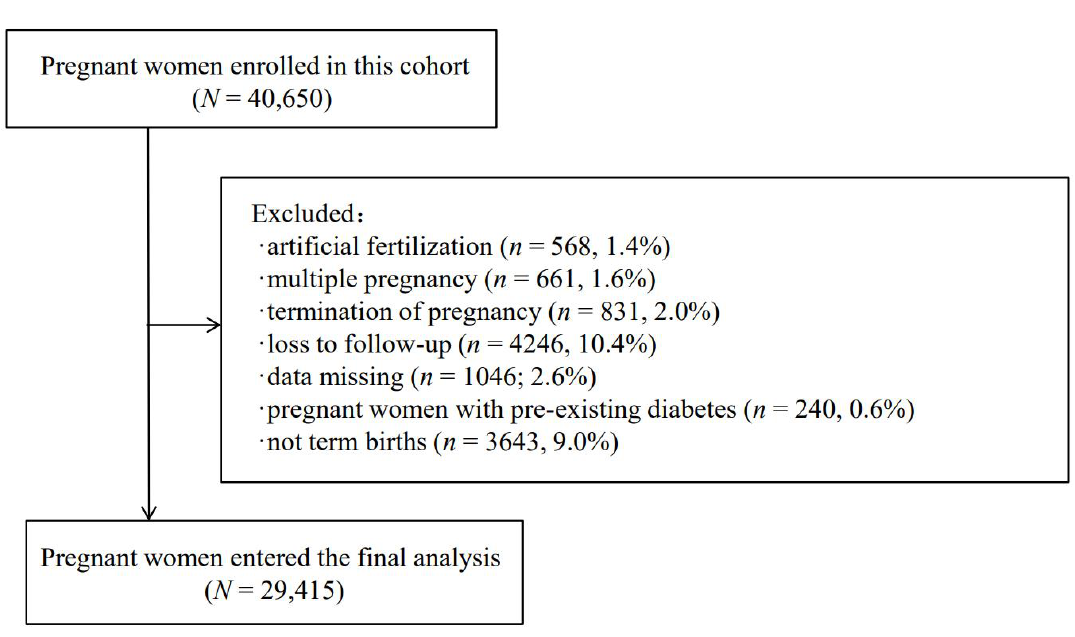
Figure A1. Flow chart depicting the participant recruiting procedure. Table A1. The total effect, direct effect, and indirect effect on the relationship of maternal over- weight/obesity and the risk of fetal macrosomia mediated by both GDM and high mTG levels when the 85th percentile was considered as the cut-off value for high mTG levels.